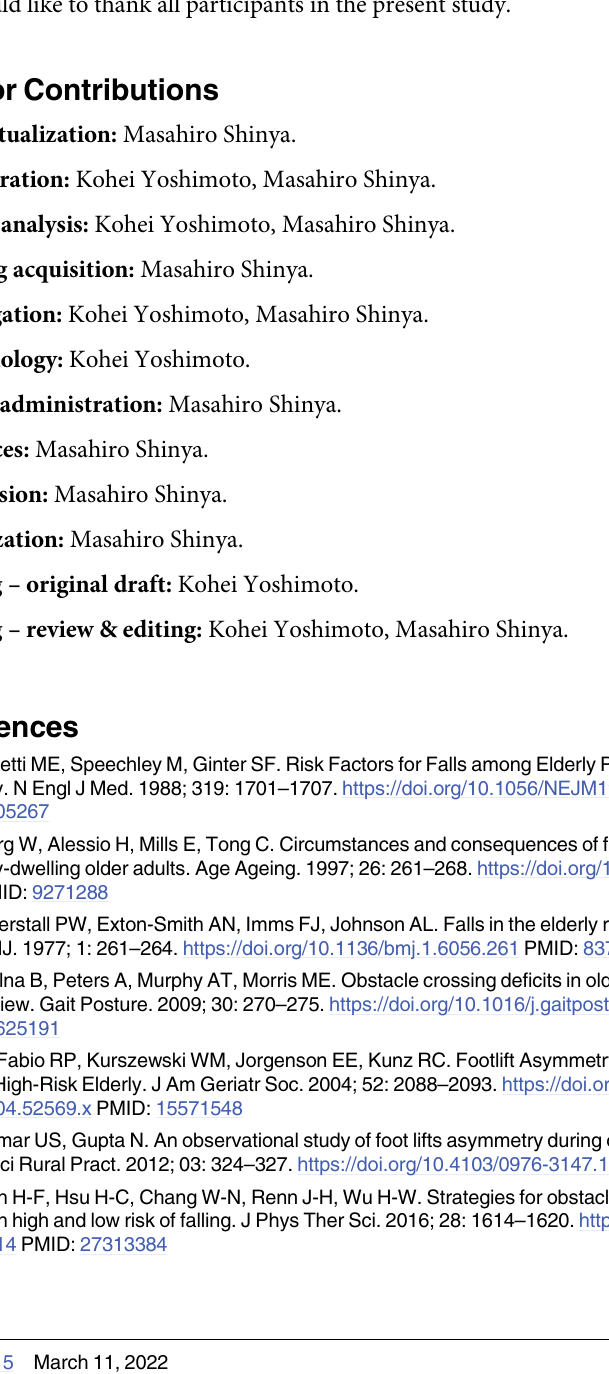
S2 Table. Within-participant systematic error of foot clearance for each limb and obstacle height. S3 Table. Within-participant random error of foot clearance for each limb and obstacle